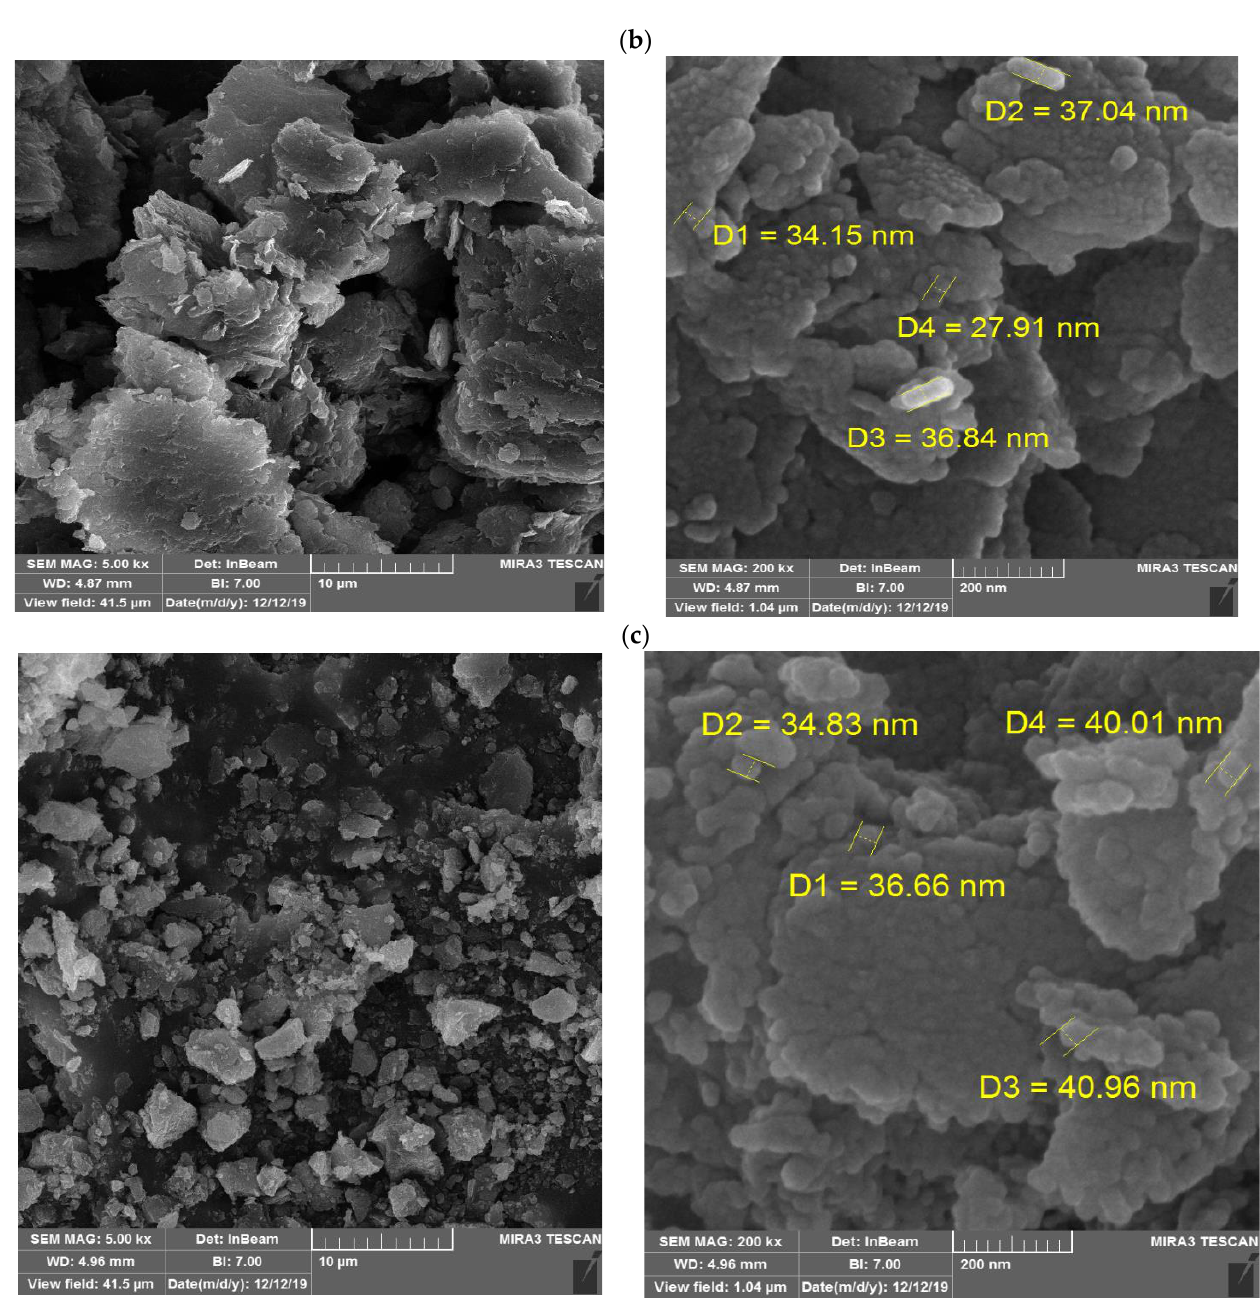
Figure 2. SEM photos for natural zeolite ( a ), activated carbon ( b ), and activated alumina ( c ).